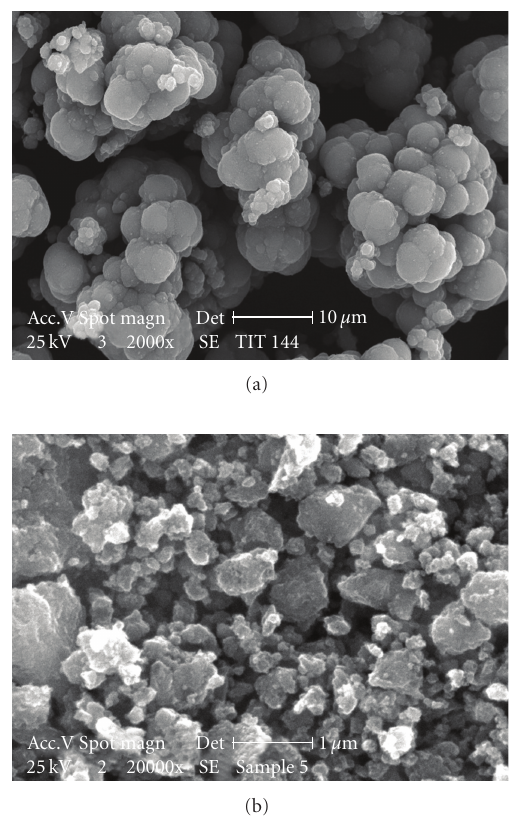
Figure 3: SEM micrographs of samples TIT 144 (initial)—(a) and TIT 144